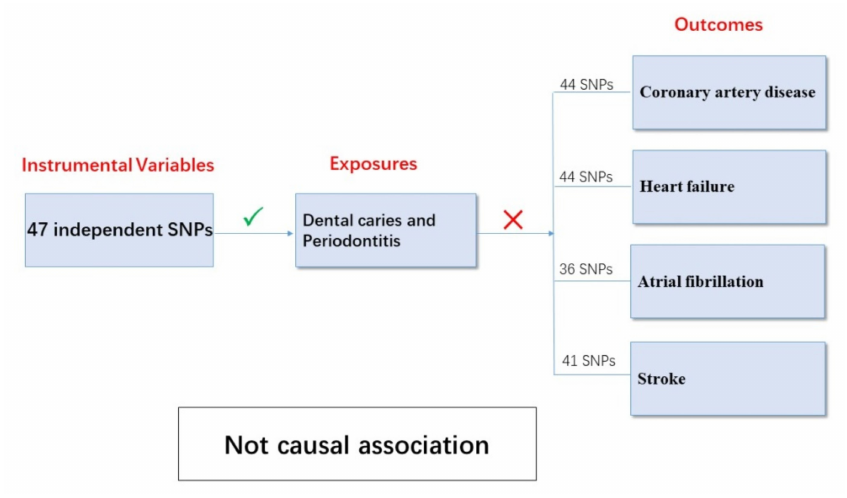
Figure 8. Association between dental caries/periodontitis and cardiovascular